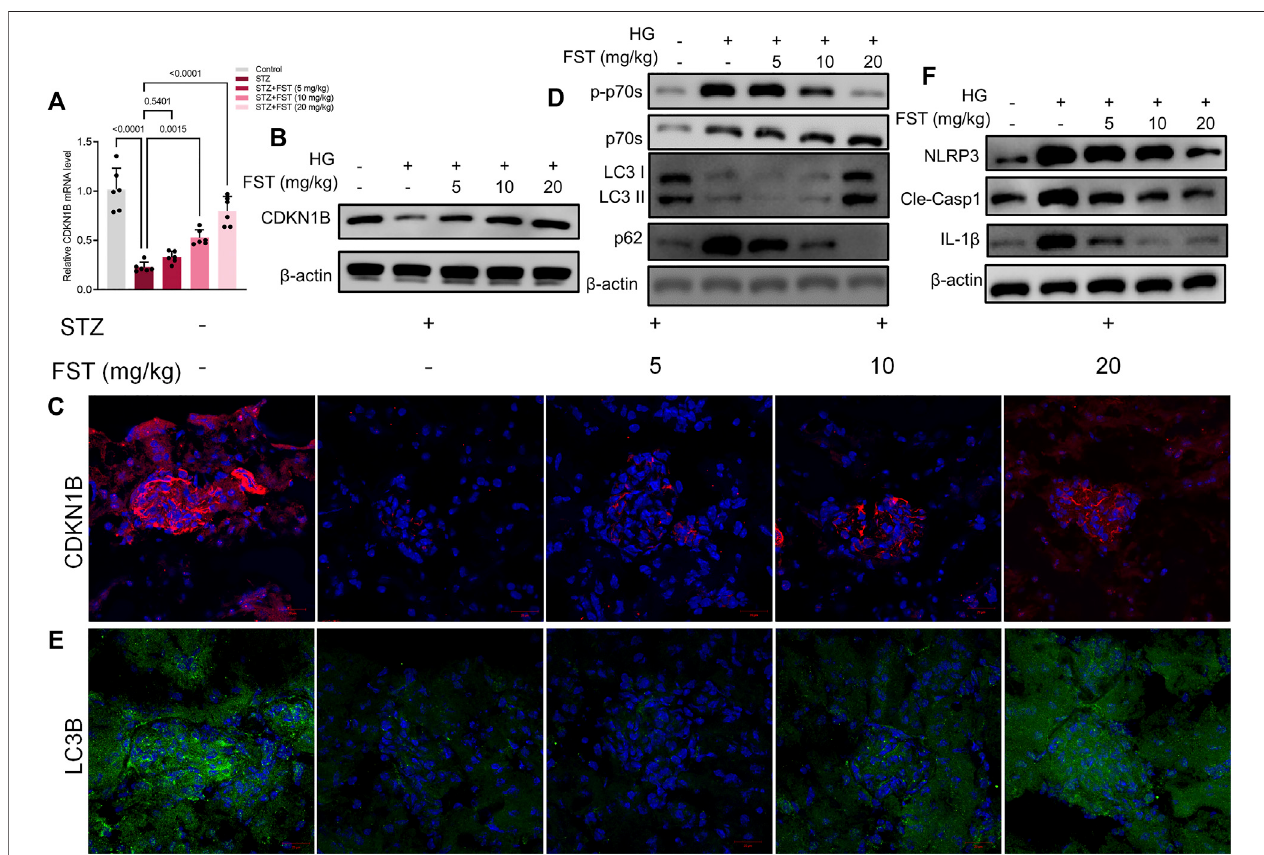
FIGURE 6 | Fisetin restored protein expression levels of CDKN1B in type 1 diabetic mice. (A) Determination of the expression levels of CDKN1B in mice kidney tissues using qRT-PCR. (B) Determination of the expression levels of CDKN1B in mice kidney tissues using western blot. (C) Representative images of immuno fl uorescence-stained sections of CDKN1B (×200) of mice kidney tissues. (D) Determination of the expression levels of phosphorylated P70S6K, P70S6K, LC3 and p62 in mice kidney tissues using western blot. (E) Representative images of immuno fl uorescence-stained sections of LC3B (×200) of mice kidney tissues. (F) Determination of the expression levels of NLRP3, cleaved caspase-1, and IL-1 β in mice kidney tissues using western blot. Data are expressed as means ± SEM ( n = 6).